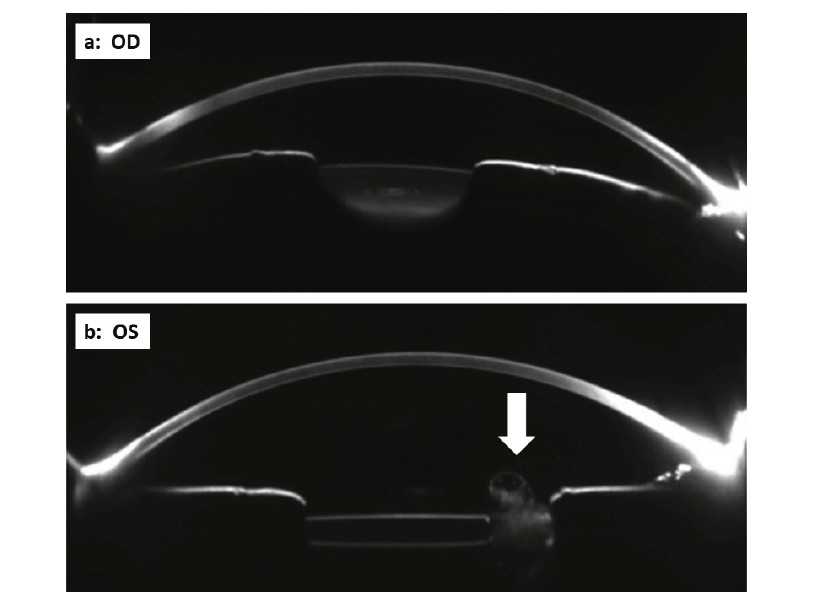
Figure 2. Scheimpflug anterior segment reconstructions of right eye (top) and left eye (bottom) captured in the clinic. The large grouping of Elschnig pearls is easily seen in the bottom